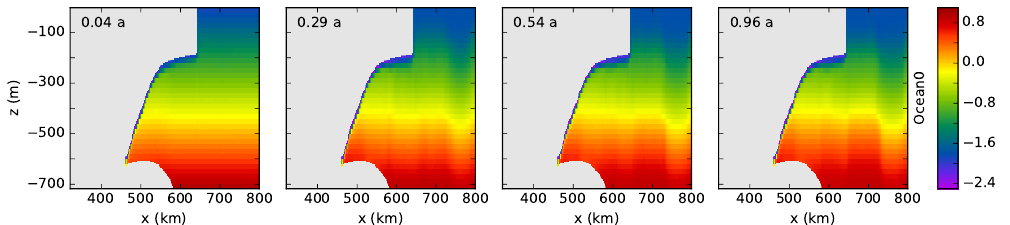
Figure 8. Example results from a 1-year Ocean0 simulation with the POP2x model using heat-transfer coefficient (cid:48) T = 0 . 11. Panels show the progression in time of transects of monthly averaged ocean temperature through the center of the domain ( y = 40km). The initial conditions and far-field restoring at the right-hand side of the domain both use the WARM profiles from Fig. 6. The ice draft does not evolve in time. The simulation reaches a quasi-steady state with relatively strong melting within a few months.